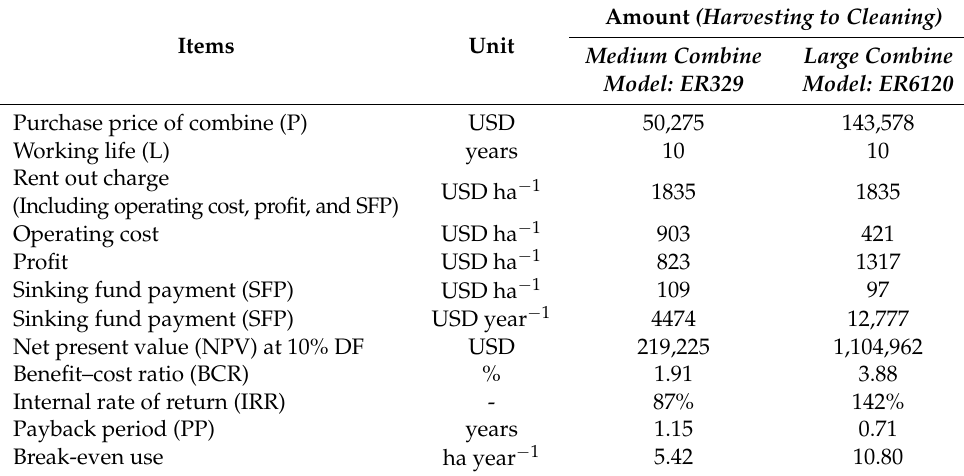
Table 6. Financial features of harvesters for custom-hire